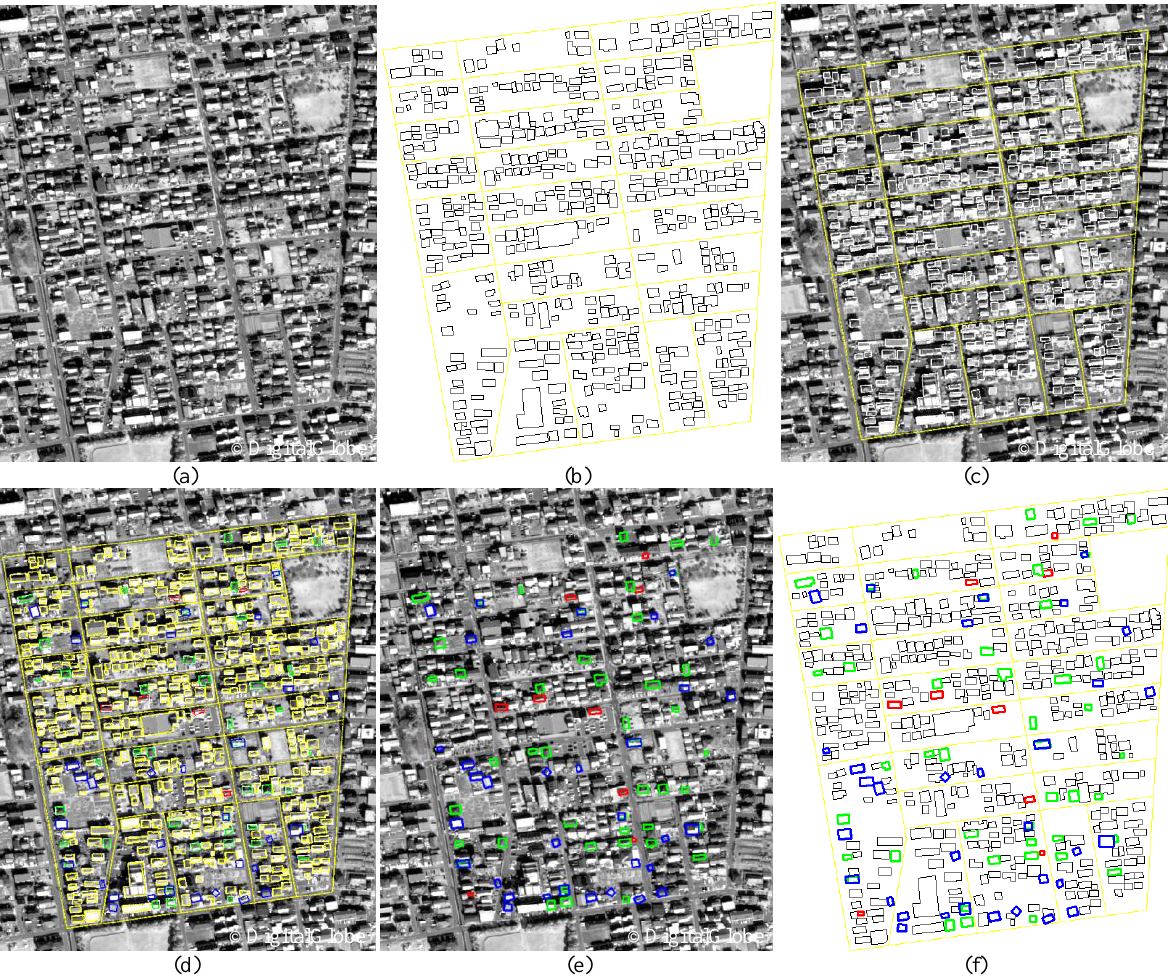
Figure 9. Experimental result of building change detection. (a)QuickBird satellite imagery (Hamamatsu city, Japan). (b)Experimental map (buildings, parcels). (c)Overlaid imagery and map. (d)Detected results. (e)Changed and newly-built buildings. (f)Updated map. (yellow=existing, red=demolished, blue=newly-built, green=need to